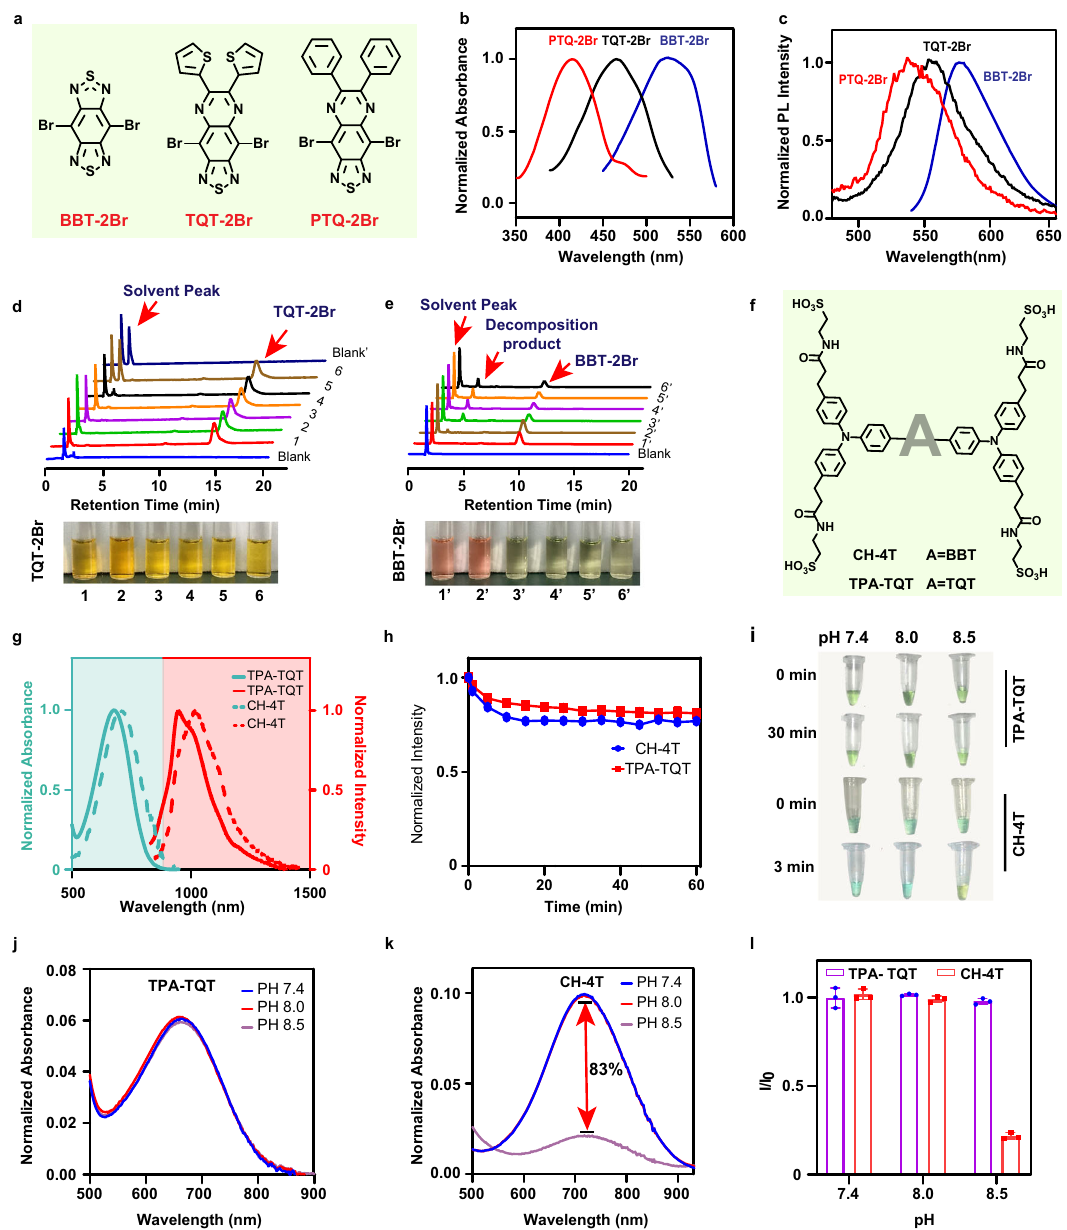
Fig. 2 The comparison of different acceptor NIR-II dyes. a Chemical structures of BBT-2Br, TQT-2Br, and PTQ-2Br. Absorption ( b ) and emission ( c ) spectra of BBT-2Br, TQT-2Br, and PTQ-2Br in dichloromethane. HPLC chromatograms of TQT-2Br ( d ) and BBT-2Br ( e ) at various acid-base conditions. Bright- fi eld images of TQT-2Br and BBT-2Br ( d , e ) in MeOH (5% DMF, 1 mL) at various acid-base conditions. 1,1 ′ : control solution; 2,2 ′ : control solution + excess tri fl uoroacetic acid (TFA); 3,3 ′ : control solution + 1 µ L Triethylamine (TEA); 4,4 ′ : control solution + 5 µ L TEA; 5,5 ′ : control solution + 10 µ L TEA; 6,6 ′ : control solution + 20 µ L TEA; Blank ’ : 50 µ L DMF + 20 µ L TEA + 930 µ L MeOH. f Chemical structures of TPA-TQT and CH-4T. g The absorption spectra and emission spectra of TPA-TQT and CH-4T in H 2 O. h Photostability of TPA-TQT and CH-4T under continuous laser irradiation (808 nm, 150 mW cm − 2 ). i Photographs of the TPA-TQT and CH-4T in PBS solutions at various pH values after 808 nm light irradiation. The absorption spectra of j TPA-TQT and k CH-4T in PBS at various pH values under 808 nm laser irradiation (150 mW cm − 2 ). l Plot of I/I 0 versus pH. I is the maximal NIR absorption intensity of TPA-TQT/CH-4T in PBS (pH 8.0, 8.5) solution, I 0 is the maximal NIR absorption intensity of TPA-TQT/CH-4T in PBS (pH 7.4) solution, respectively. Data are presented as mean ± s.d. derived from n = 3 independent Chemical stability evaluation of BBT and TQT based dyes . To Key steps used to assemble the core structures of the target compound included Suzuki cross-coupling reaction, zinc reduc- examine the chemical stability of BBT and TQT based dyes in the tion, and ring closure. To enhance the water solubility of the FT presence of reactive oxygen/nitrogen species (ROS/RNS), metal dyes, four sulfonic groups were introduced into the chemical ions, and active biomolecules, we measured the absorption structures. The detailed synthetic procedures and characterization spectra of CH-4T, FT-BBT, TPA-TQT, and FT-TQT after incu- are described in the Supporting Information (Supplementary Fig. 2 and Supplementary Figs. 33 – 44).